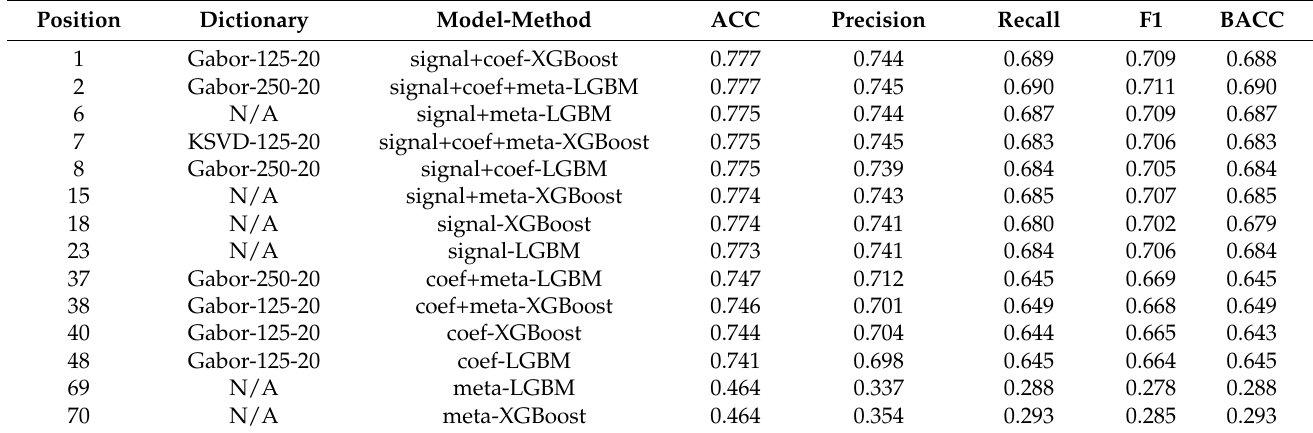
Table 7. Summary of average metrics scores for each data model, class size =